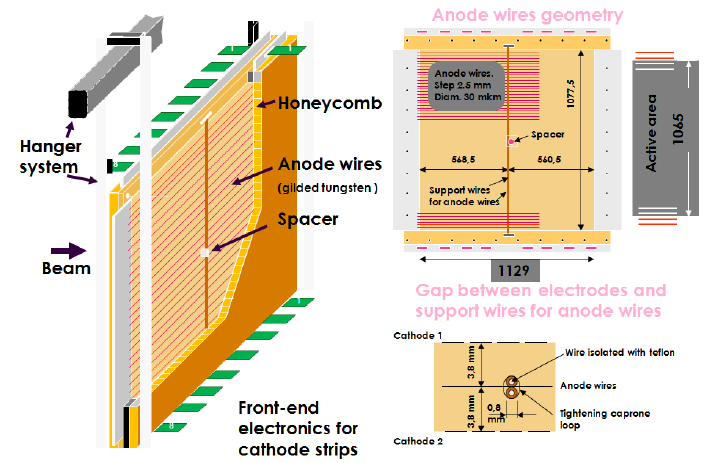
Figure 2. Schematic view of Cathode Strip Chamber